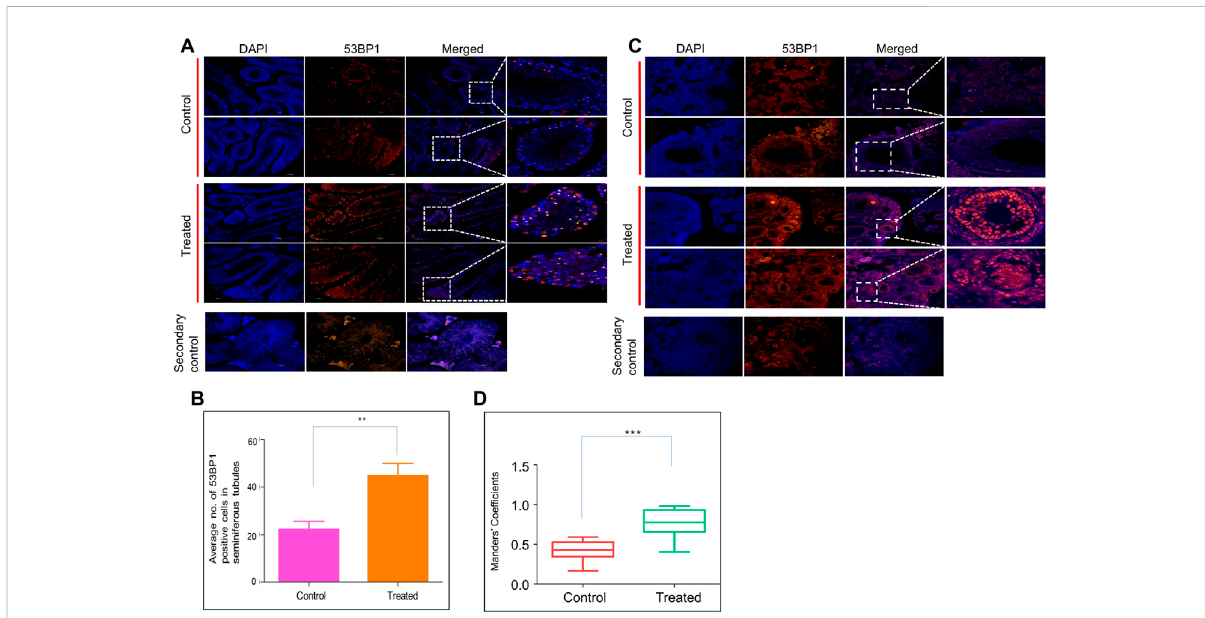
FIGURE 5 Evaluation of ES induced DNA breaks in mice reproductive organs. To evaluate the long-term effects of ES, mice ( n = 2) were exposed to ES (5 mg/kg,10doses),andtissuesampleswerecollectedafter8monthsandexaminedfor53BP1foci,ahallmarkofDSBs. (A) Immuno fl uorescencefor 53BP1 expression in testis of ES treated mice. Control indicates sections of testes from untreated control mice, while treated refers to sections from testesofES-exposedmice. (B) Bargraphindicatestheaveragenumberof53BP1positivecellsincontrolandtreatedmiceseminiferoustubules. (C) Immuno fl uorescence of 53BP1 expression in ovary of control and ES treated mice. Control indicates ovary sections from untreated mice, whereas ES is sections from treated mice. The experiments were repeated two independent time. (D) Bar graph indicates number of 53BP1